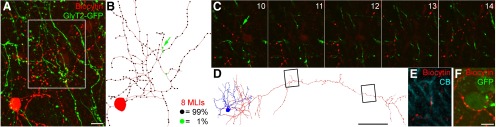
GlyT2-GFP-expressing dendrites receive negligible inputs from MLI axons. A, Maximum intensity projection image of a confocal image Z-stack of an in vitro recorded and biocytin (red)-labeled MLI with axons spreading among GlyT2-GFP-expressing processes (green). Scale bar: A (for A–C), 10 μm. B, Neurolucida reconstruction of the soma and axon of the recorded cell (red; black circles indicate varicosities; green circles indicate varicosities next to GlyT2-GFP-expressing dendrites). The number of reconstructed cells and the percentage occurrence of each varicosity type are indicated. C, Boxed area in A shown as a series of confocal image planes highlighting a single putative contact (green arrow). Note that most varicosities of the biocytin-filled axon have unlabeled targets, despite numerous GlyT2-GFP-expressing structures in the vicinity. D, Neurolucida reconstruction of a different MLI (soma and dendrites in blue, axon in red). Scale bar, 50 μm. Boxed regions correspond to the fluorescent images shown in E (left) and F (right). E, The axon of the MLI in D makes a bouton in apposition (red) to a calbindin-immunoreactive (CB; cyan) Purkinje cell dendrite. F, The same axon also has several boutons in close apposition with a weakly GlyT2-GFP-labeled MLI soma (GFP; green). Scale bar: F (for E, F), 5 μm.